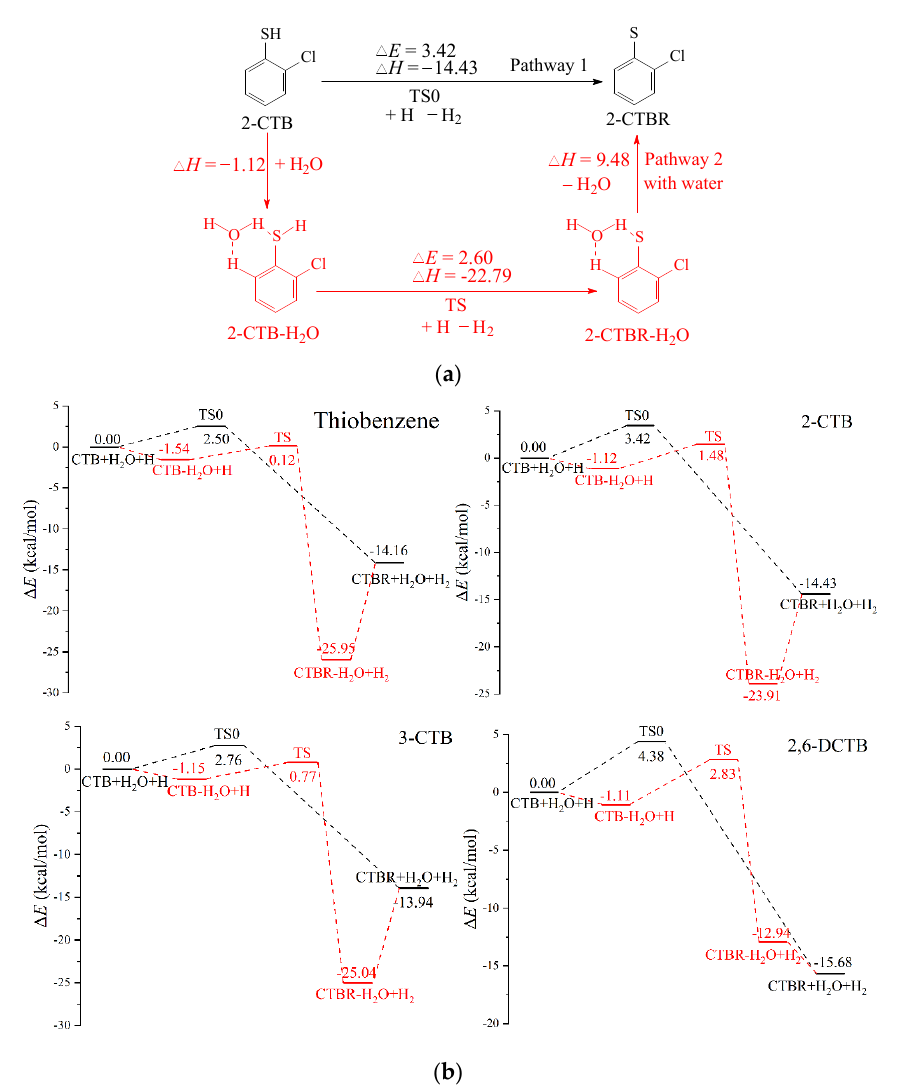
Figure 3. The reaction mechanism ( a ) and schematic energy profile ( b ) of the H abstraction from TBe, 2 ‐ CTB, 3 ‐ CTB, and 2,6 ‐ DCTB by H atom in hydrated and non ‐ hydrated cases. Δ E and Δ H are calculated at 0 K.